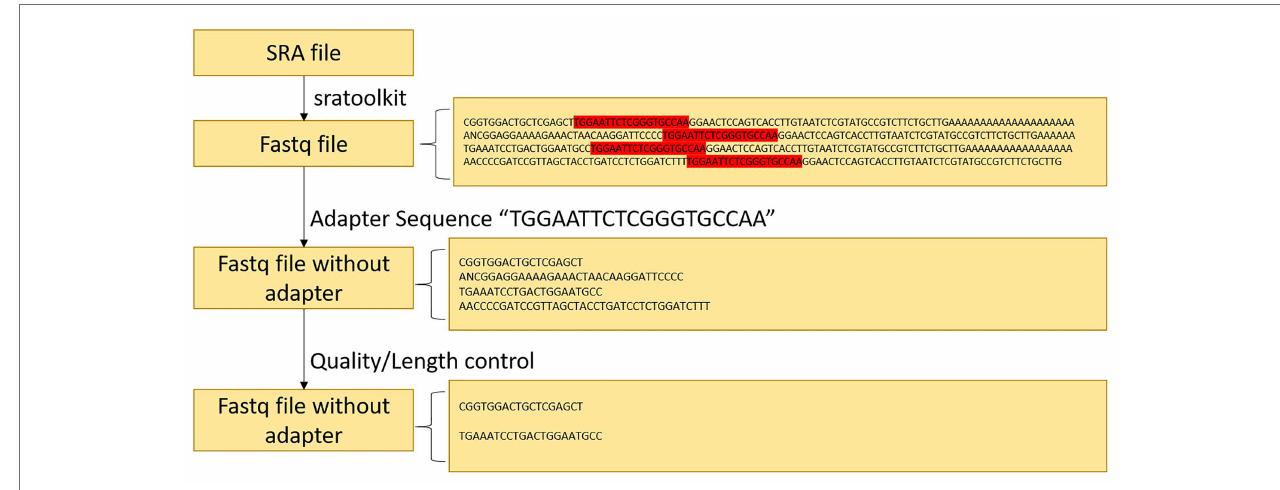
FIGURE 2 | Data preprocessing